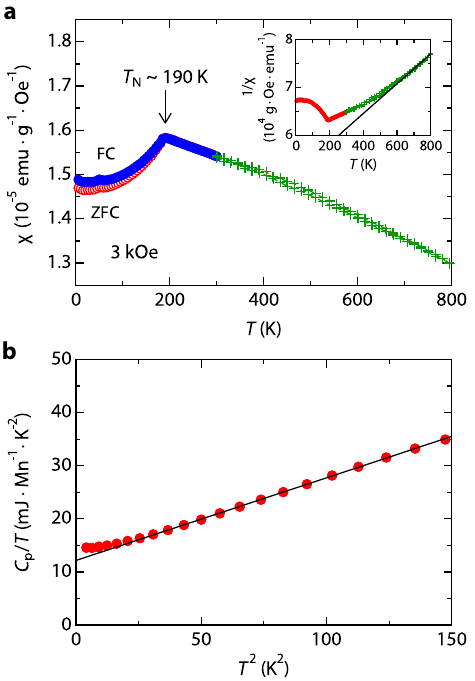
Fig. 4 Magnetic susceptibility and speci fi c heat capacity. a Temperature dependence of zero- fi eld-cooled and fi eld-cooled magnetic susceptibilities χ ( = M / H ) under a magnetic fi eld of 3 kOe for a polycrystalline sample of Mn 3 RhSi. The crosses denote measurements in a high-temperature SQUID furnace. The inset shows the inverse magnetic susceptibility. The black solid line is a Curie – Weiss fi t in the temperature range from 700 to 800 K. b Low-temperature speci fi c heat capacity of Mn 3 RhSi. The electronic speci fi c heat γ is estimated as 12.18 ± 0.03 mJ Mn − 1 K − 2 , and the Debye temperature θ D is 275.2 ± 0.2 K.